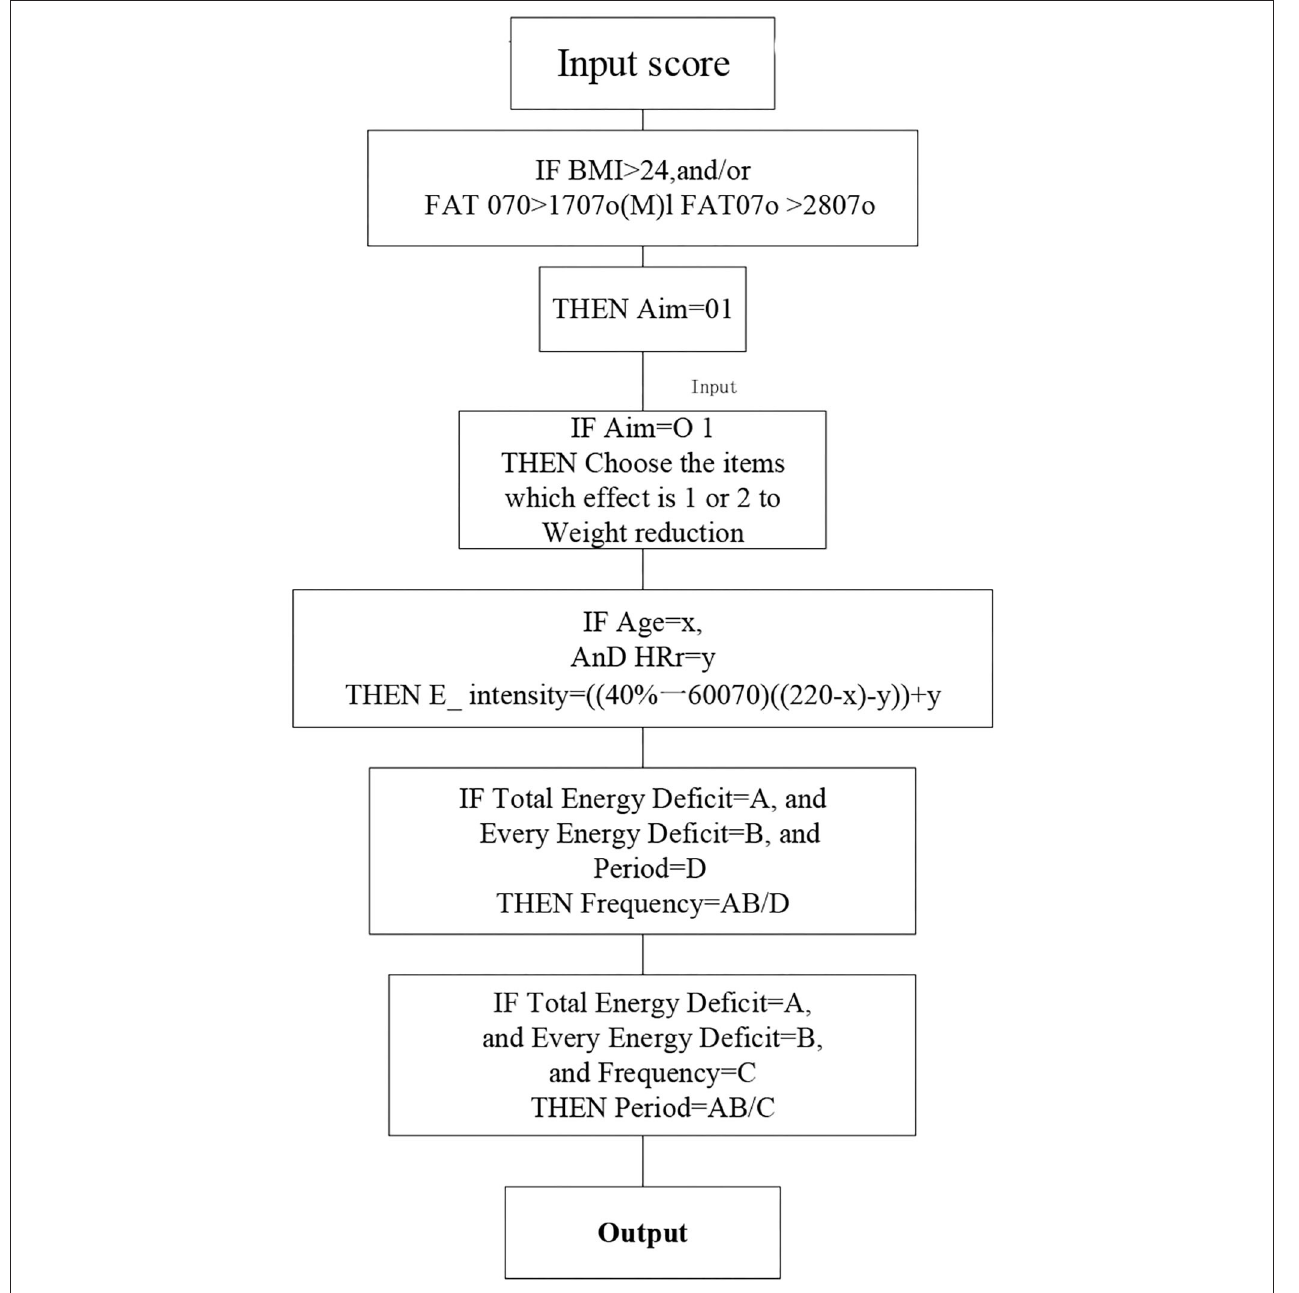
FIGURE 20 | The specific framework of the sport guidance